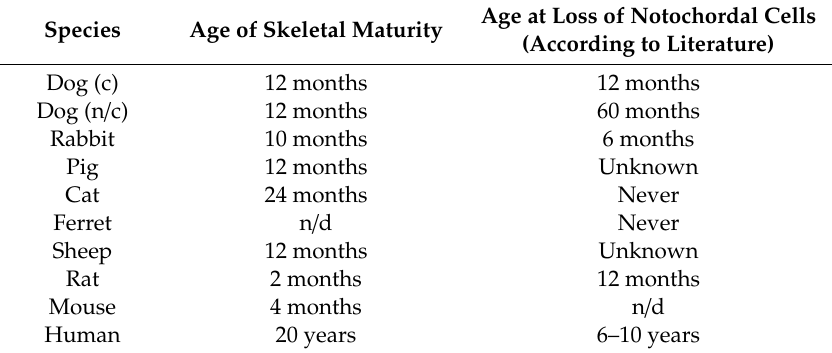
Table 1. Summary of notochordal cells indi ff erent